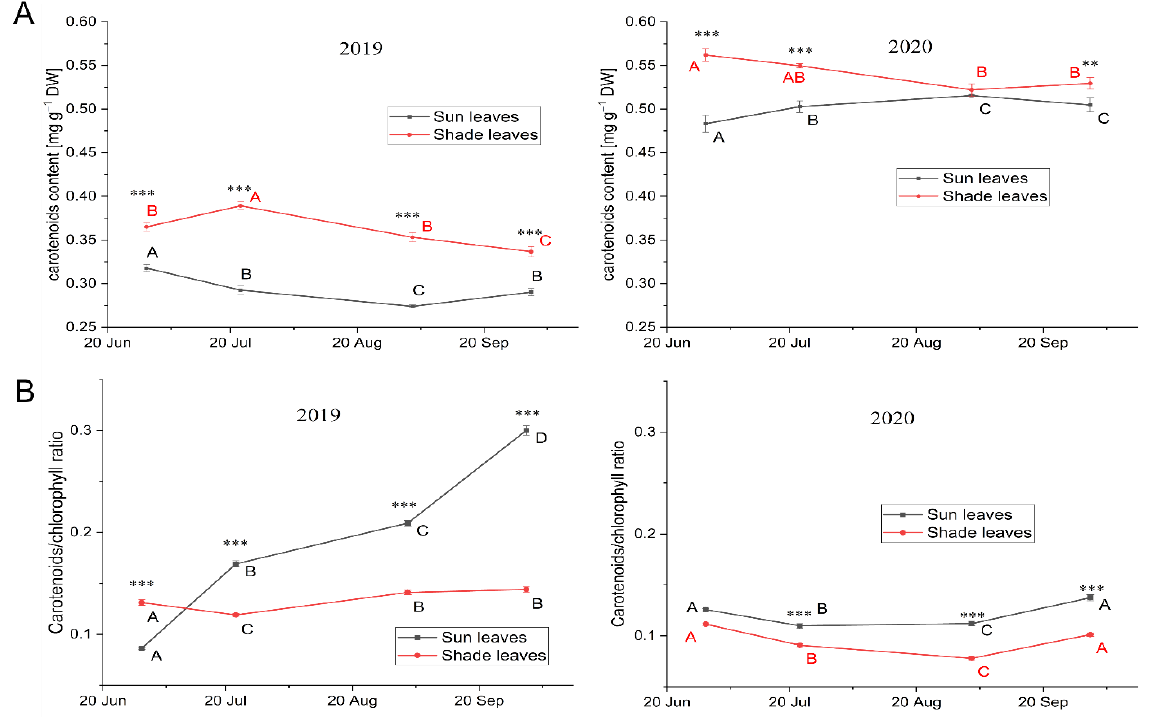
Figure 3. Changes in the carotenoid content ( A ) and carotenoid/chlorophyll ratio ( B ) in the sun and shade senescing beech ( Fagus sylvatica L.) leaves. Analyses were performed for sun (black line) and shade (red line) leaves in 2019 and 2020. Each point is the mean of 60 measurements (±standard error). For each type of leaves, means with different uppercase letters differ significantly at p < 0.05. For each date, means with asterisks differ significantly at ** — p < 0.01 and *** — p < 0.001.